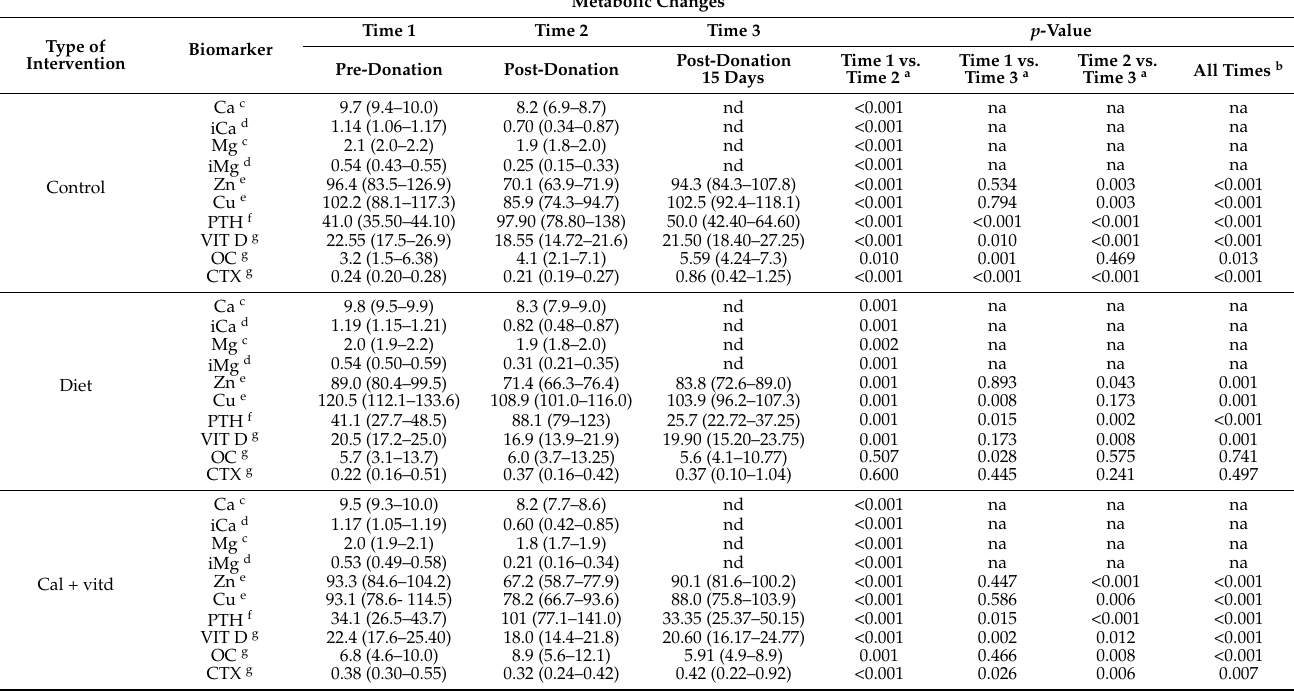
Table 3. Metabolic changes post-donation in plateletpheresis